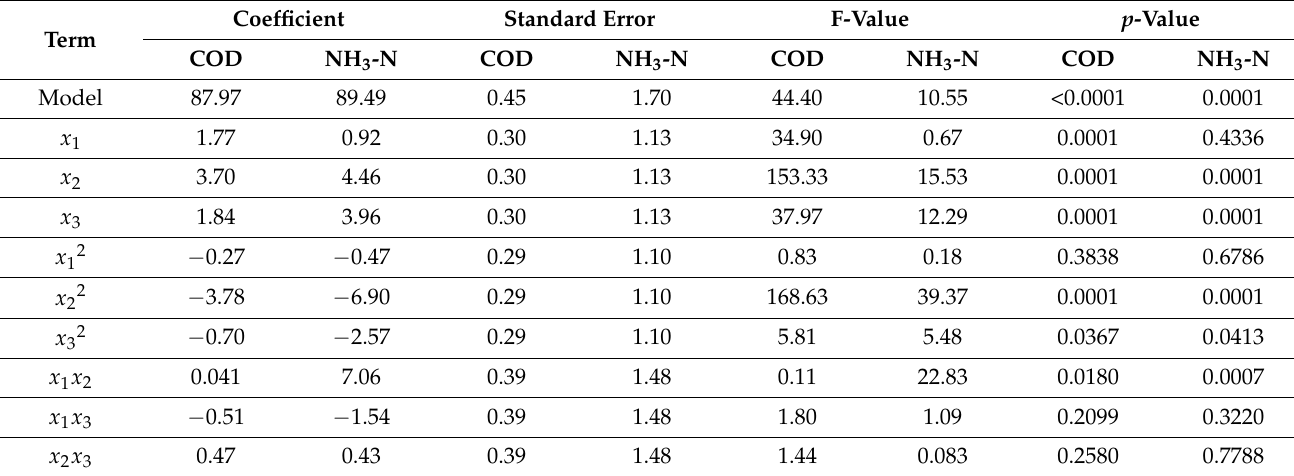
The significant negative quadratic interaction coefficient between temperature and coagulant doses inhibited the FeSO 4 · 7H 2 O waste coagulation. However, the negative coef- ficient of the interaction between the temperature and coagulation time was insignificant, indicating that the increased coagulation time at a higher temperature did not influence the percentage NH 3 -N and COD elimination from SRPE. The statistically significant second- order quadratic model reveals the aptness of the variables for the elimination of NH 3 -N and COD from SRPE. The second-order quadratic model can be represented in terms of coded factors, as shown in Equations (4) and (5):